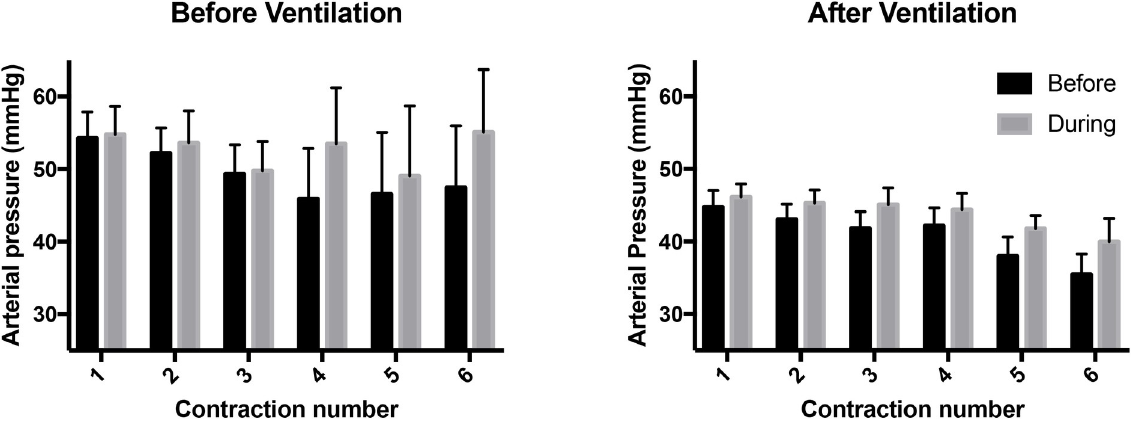
Fig 6. Mean carotid arterial (CA) pressures measured immediately before (black bar) and during (grey bar) consecutive uterine contractions and before (BV) and after ventilation (AV) onset. Arterial pressures measured during each contraction were significantly higher than pressures measured immediately prior to the contraction (p <